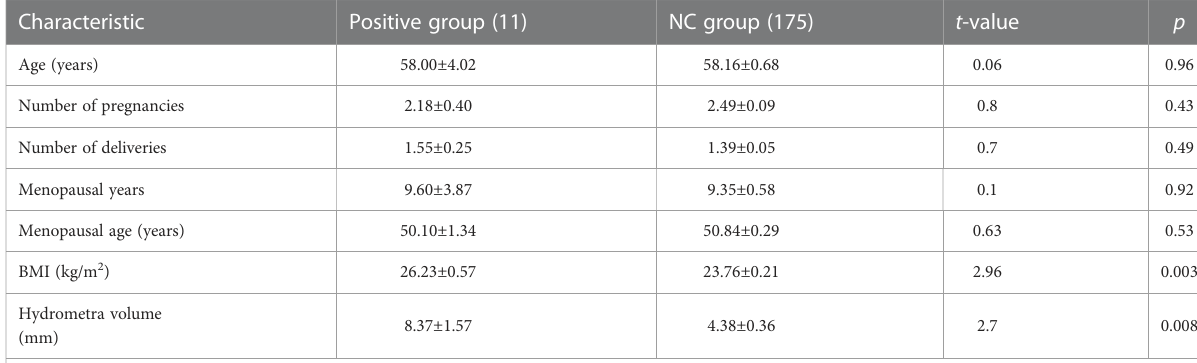
TABLE 3 Characteristics of patients with